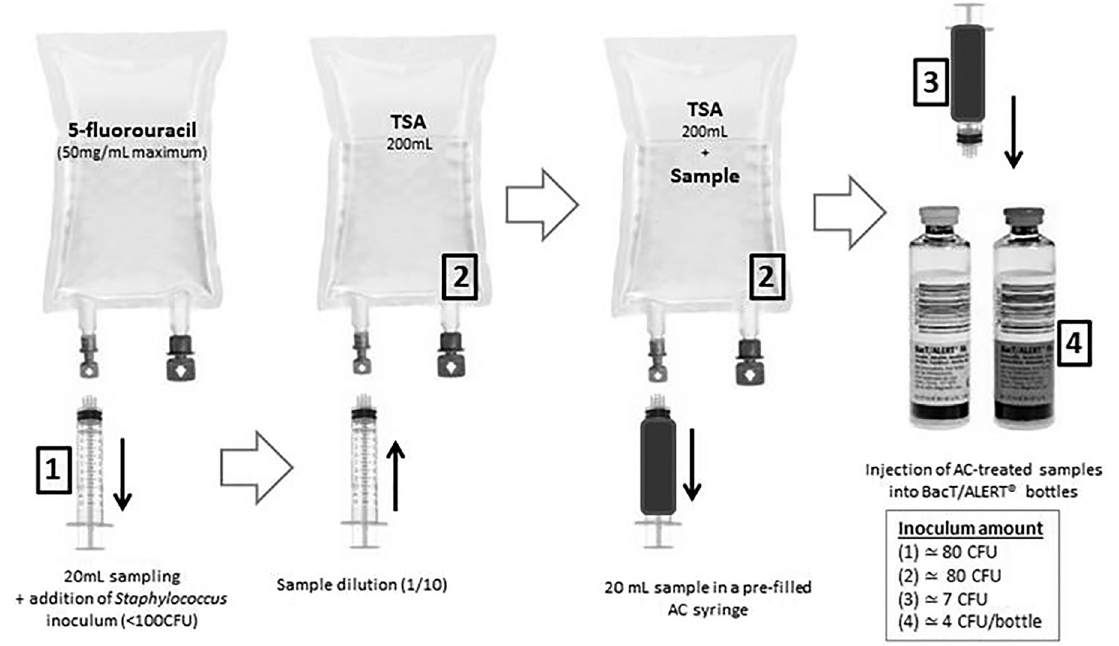
Figure 2: Method for routine implementation. (1) Sampling 20 mL sample; (2) Sample dilution in Tryptone soya; (3) Sampling with a pre- fi lled AC syringe; (4) Incubation in BA